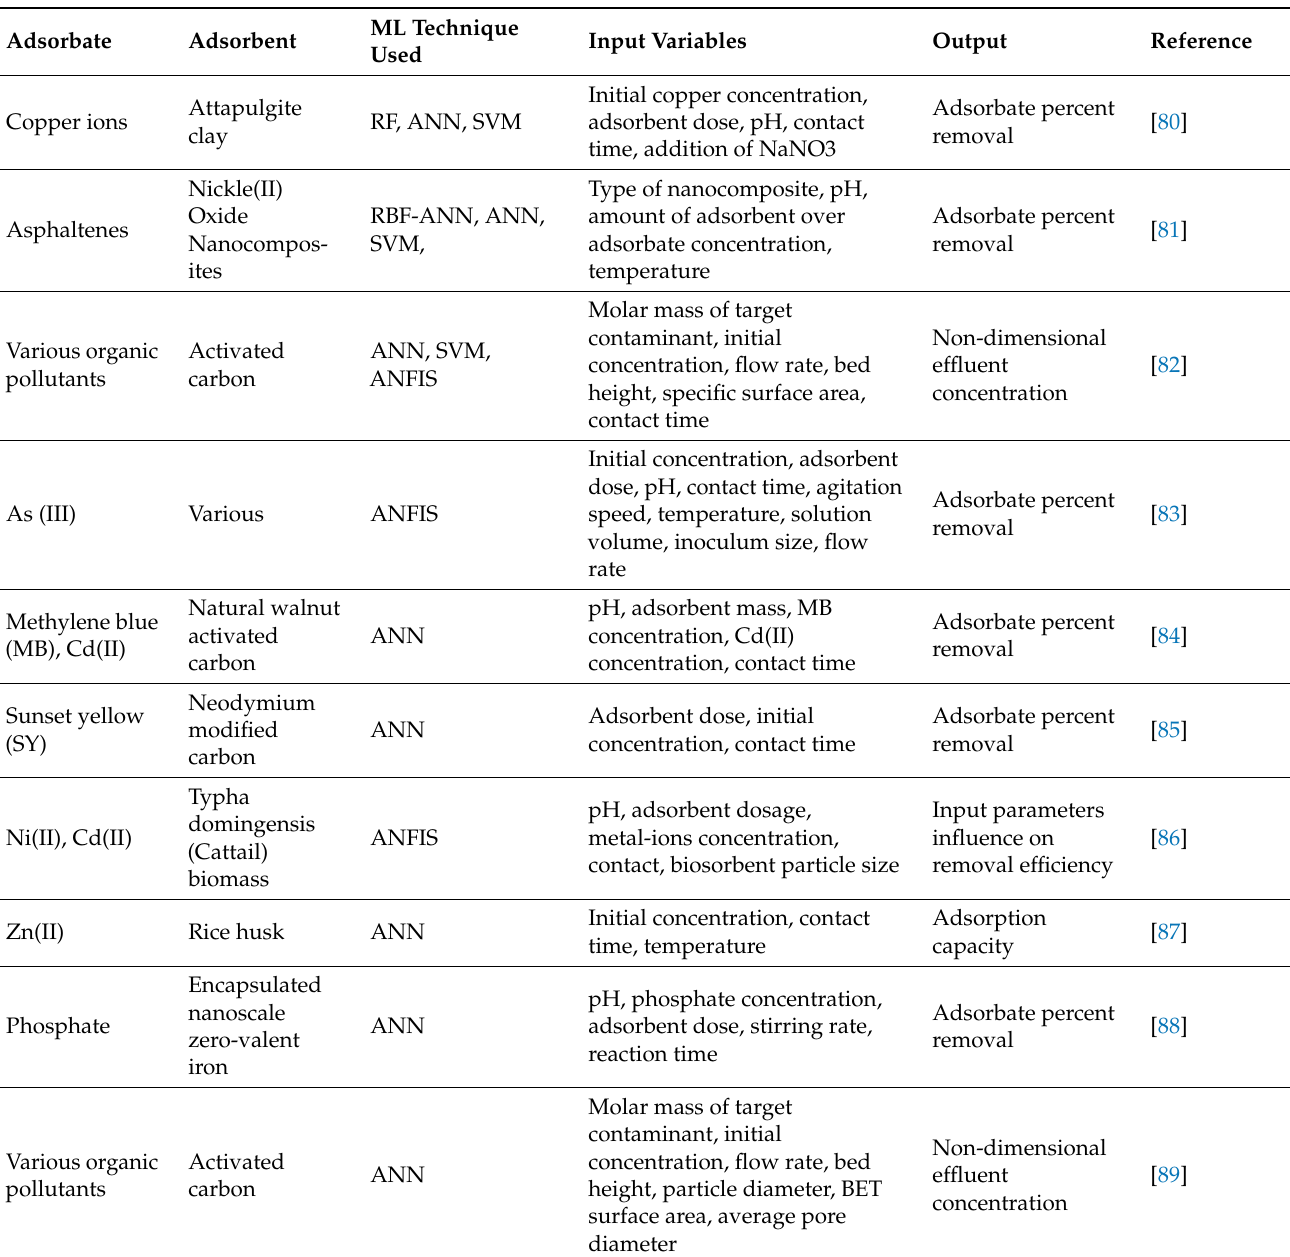
Table 3. ML to model and predict adsorption processes and removal